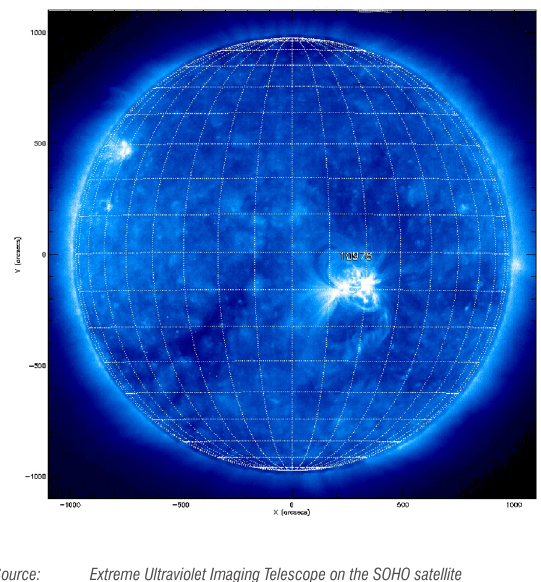
Figure 1: The solar corona in extreme ultraviolet light (17.1-nm band) at 10:03 UTC on 13 December 2007.